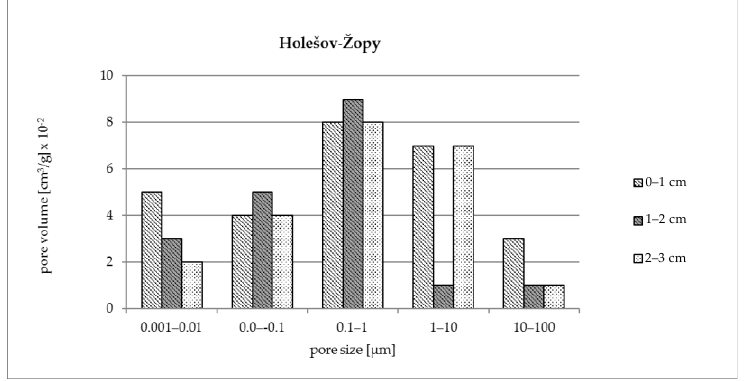
Figure 2. Pore size distribution of individual layer of the brick: Vysoké Mýto (0 – 1 cm, 1 – 2 cm, 2 – 3 cm from the cover).